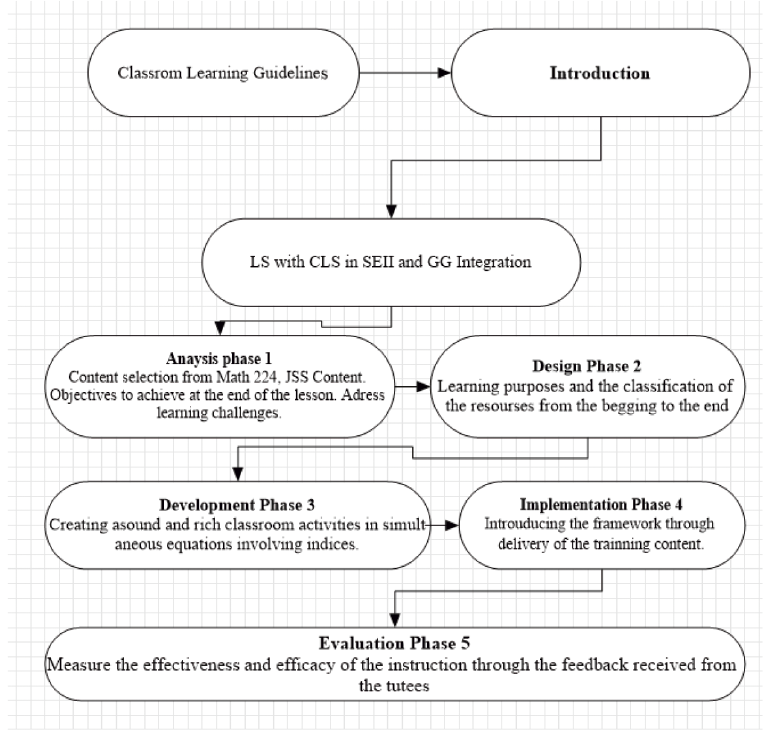
Figure 4. ADDIE model flow